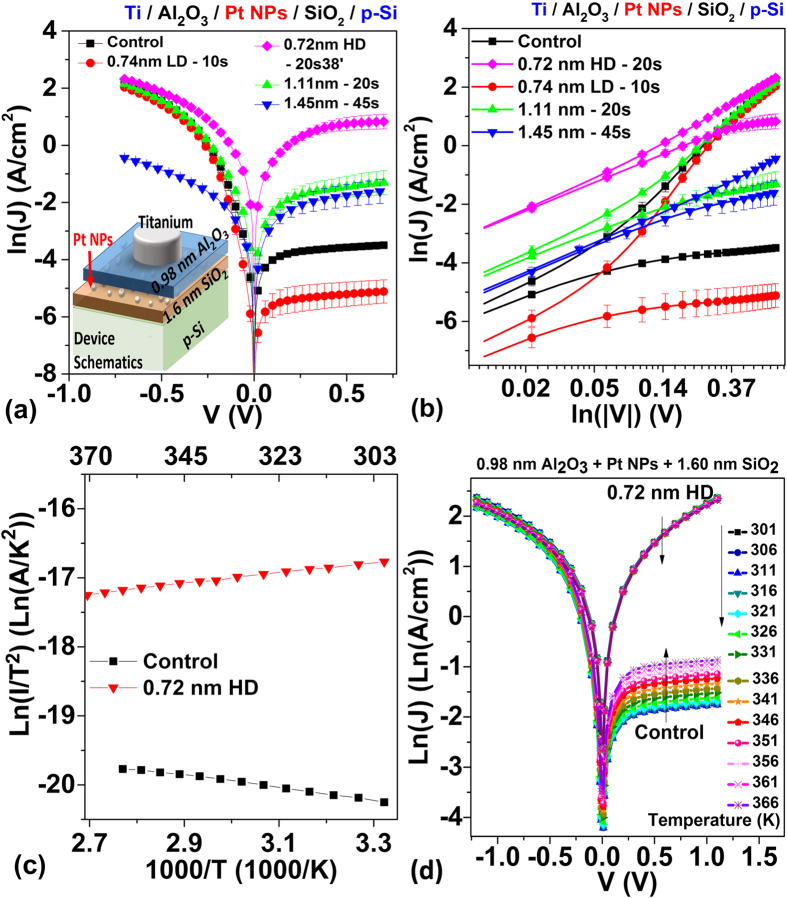
Comparison of Ti-p Si contact with different size of Pt NPs sandwich between the 0.98 nm Al2O3 and 1.6 nm SiO2 (a) Ln(J)-V characteristics. Inset: Schematics of device structures; (b) Ln(J)- Ln(|V|) characteristics; (c) the Richardson plots. (d) Ln(J)-V-T characteristics.